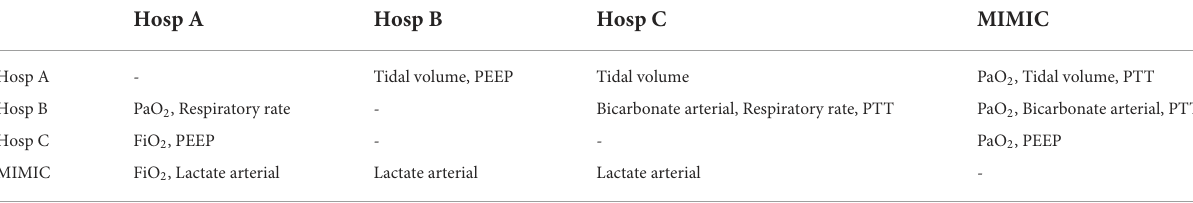
TABLE 3 Lists of parameters with low CH intersections for all pairs of hospitals.